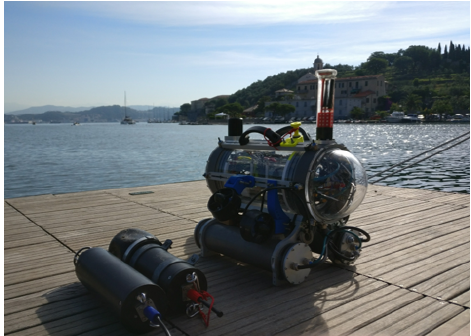
Figure 1. FeelHippo AUV designed and built by the Department of Industrial Engineering of Florence